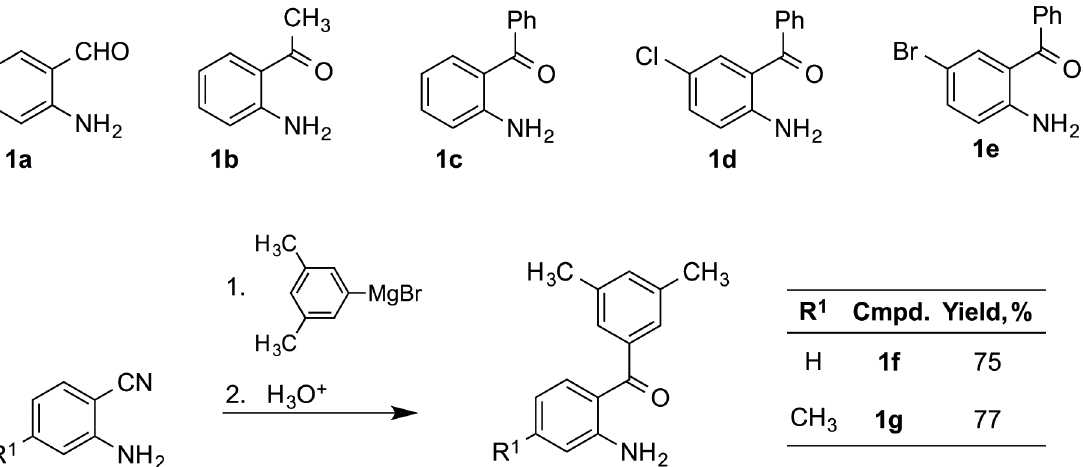
Figure 2. Preparation of synthetic precursors. Compounds 1a – d are commercially available. Compound 1e was prepared by bromination of 1c , using a literature method. Compounds 1f and 1g were prepared by addition of 3,5-dimethylphenylmagnesium bromide to the corresponding 2-